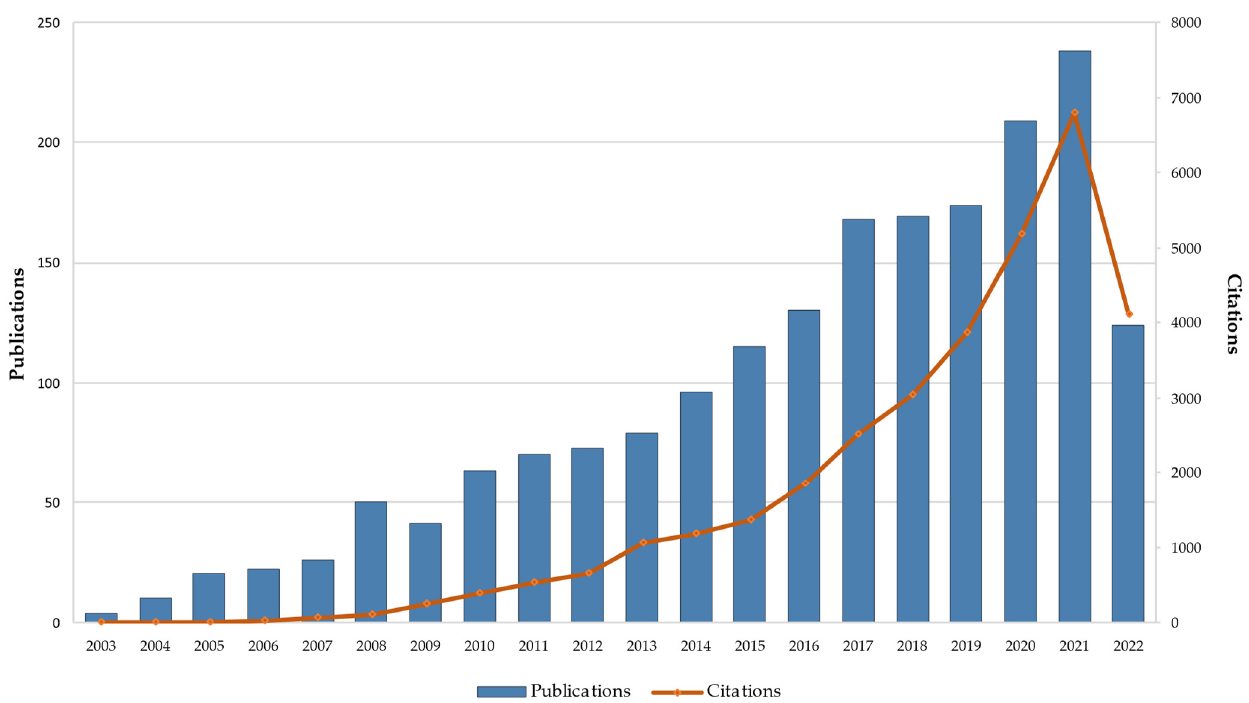
Figure 2. The number of publications on the BM&OI and number of global citations received in the period of 2003–2022.